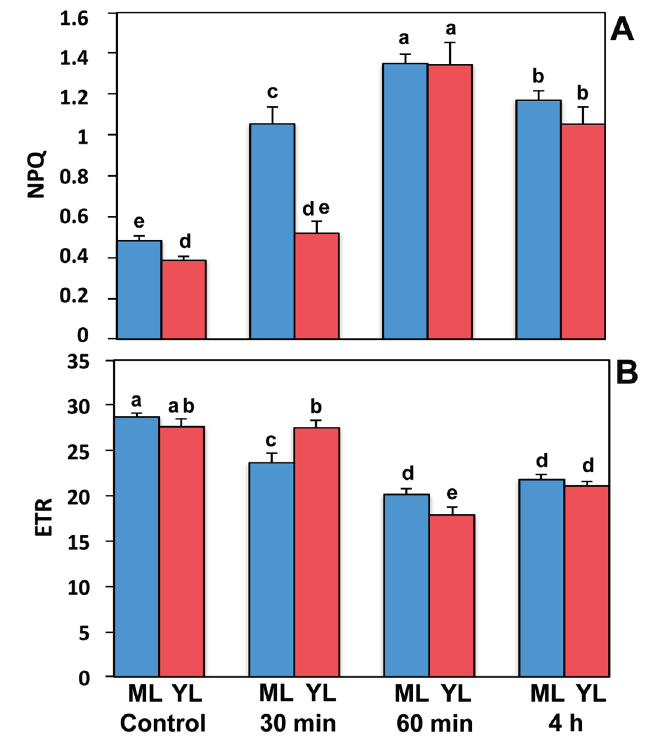
Figure 1. Changes of ( A ) non-photochemical quenching (NPQ); and ( B ) electron transport rate (ETR), of control and after 30 min, 60 min, and 4 h Pq exposure of A. thaliana mature (ML) and young leaves (YL). Blue columns: mature leaves; red columns: young leaves. Data shown are means ± SE indicated by bars ( n = 6). Columns with different lowercase letters are significantly different ( p <